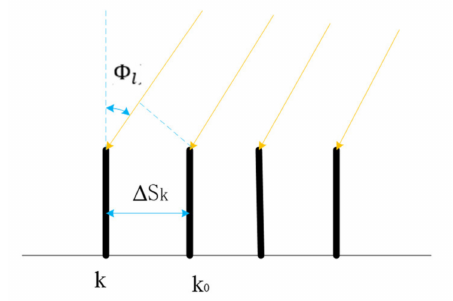
Figure 3. Array signal